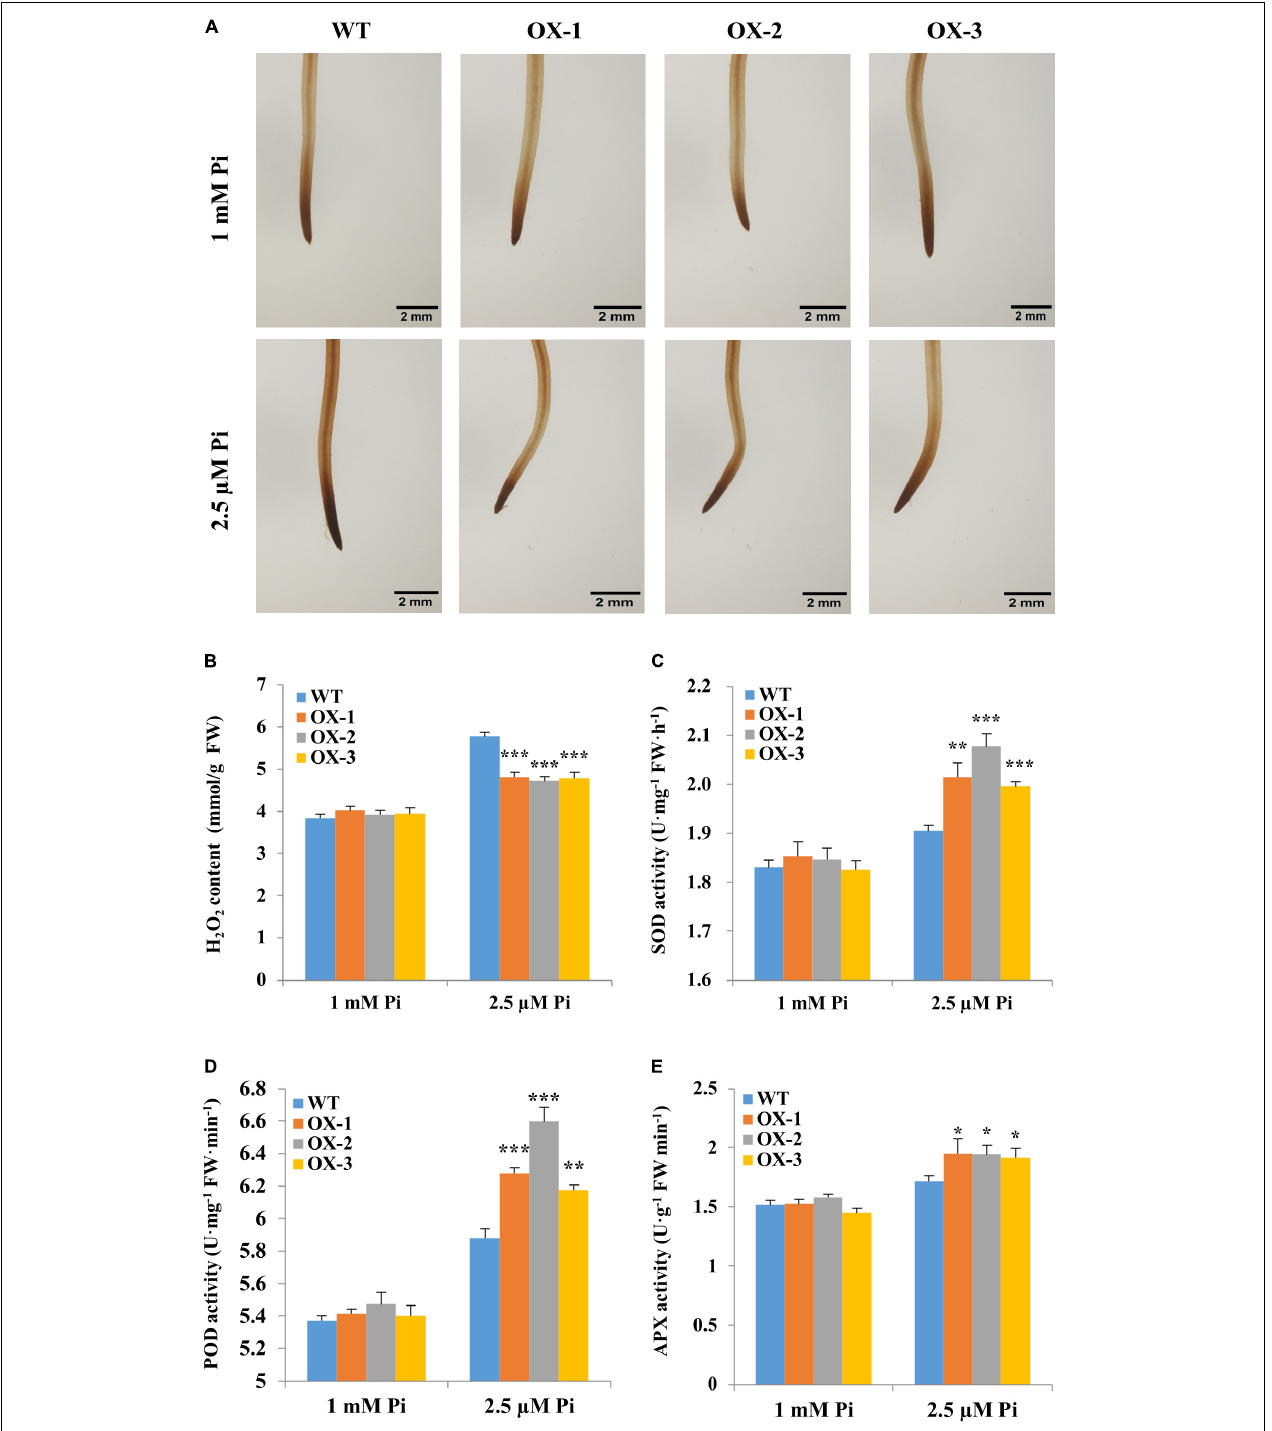
FIGURE 5 | Changes in levels of H 2 O 2 accumulation and activities of ROS-scavenging enzymes of soybean root tips during Pi starvation. Five-day-old soybean seedlings (removal of cotyledons) were exposed to nutrient solutions containing two levels of Pi, 1 mM Pi (Pi-sufficient) or 2.5 µ M Pi (Pi-deficient) for 10 days. (A) Results from DAB staining to detect H 2 O 2 . Scale bar = 2 mm. (B) H 2 O 2 content. (C) Superoxide dismutase (SOD) activity. (D) Peroxidase (POD) activity. (E) Ascorbate peroxidase (APX) activity. The root tips of wild-type (WT) and Gm6PGDH1 -overexpressing lines (OX-1, OX-2, and OX-3) are used as substrates for detection. These data were measured on day 10 of both Pi treatments. Data are means of the three replicates with SD. Asterisks show that the values are significantly different between the transgenic lines and the WT at the same time point (Student’s t -test, * P < 0.05, ** P < 0.01, *** P < 0.001).